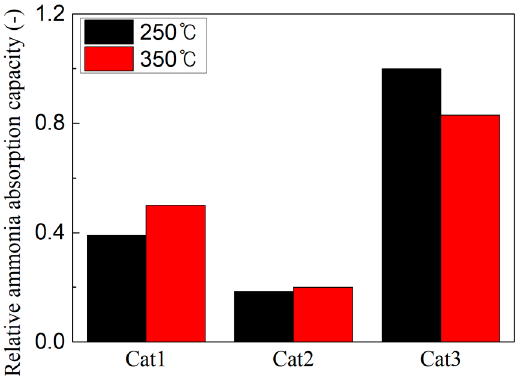
Figure 6. Relative ammonia adsorption capacity at 250 °C and 350 °C.